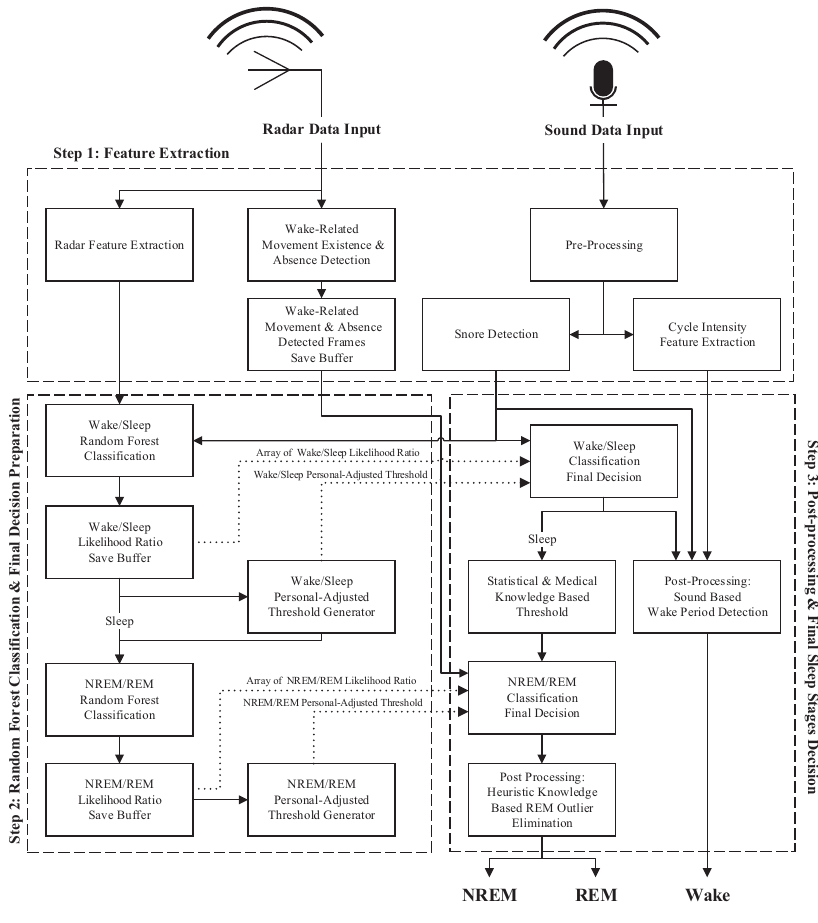
Figure 2. Block diagram of the proposed